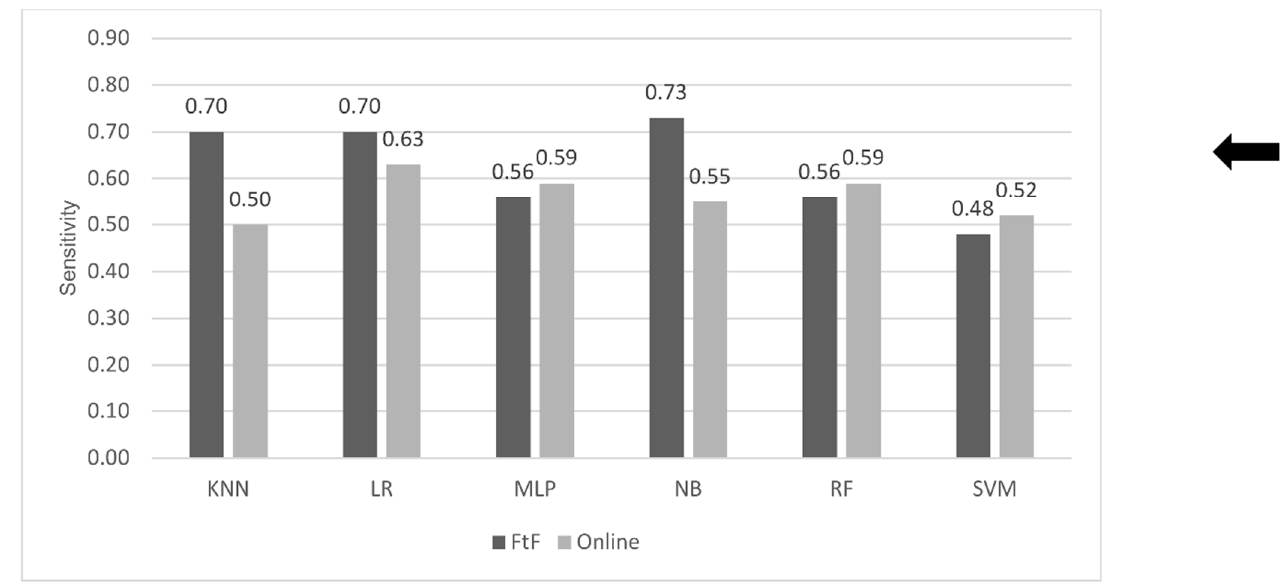
Figure 1. Prediction of at ‐ risk students (sensitivity scores) by instructional modality and algorithm.